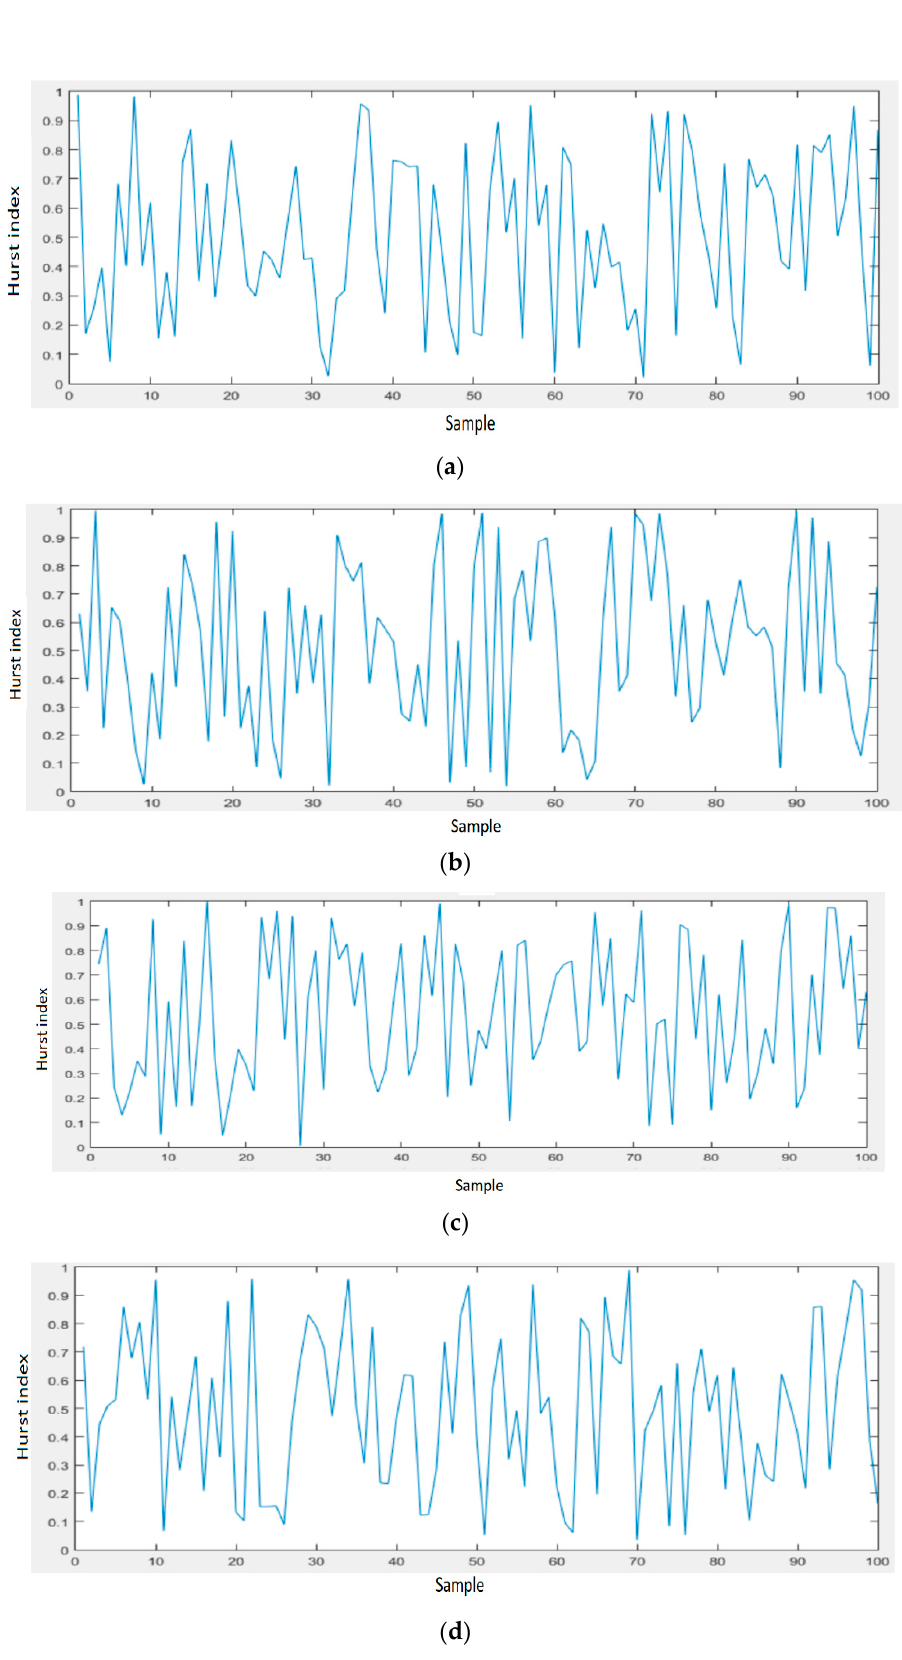
Figure 17. Representation and analysis of network traffic on the signal obtained from the decompo- sition on level 3, using the function sym6: ( a ) H = 0.39, ( b ) H = 0.46, ( c ) H = 0.29, and ( d ) H = 0.15.